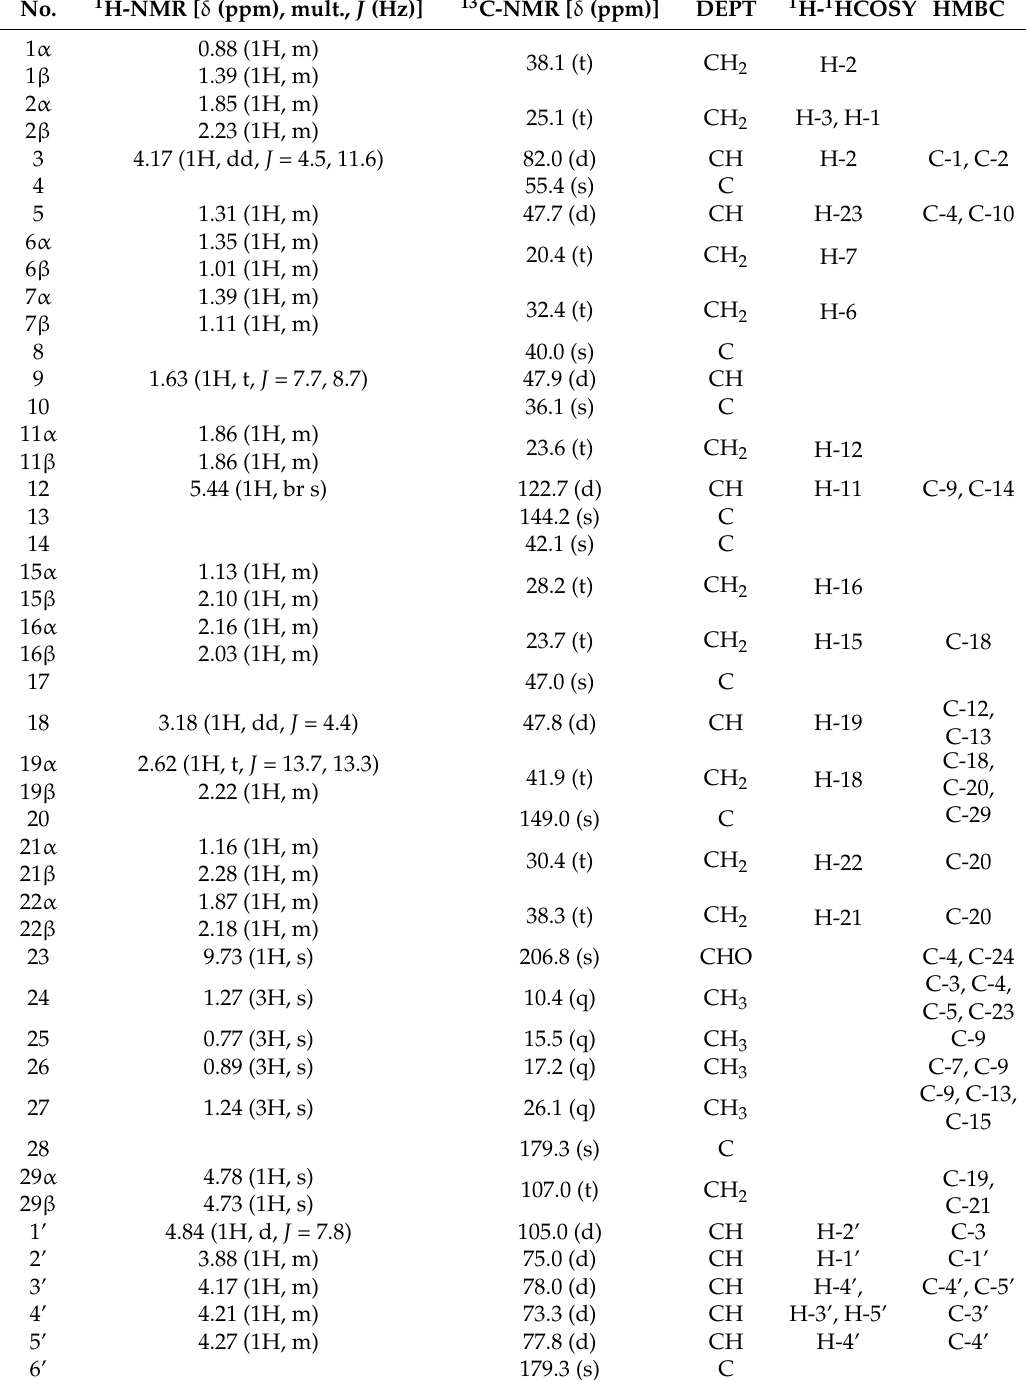
Table 1. NMR spectroscopic data for compounds 11 in pyridine- d 5 ( 1 H: 500 MHz, 13 C: 125 MHz).